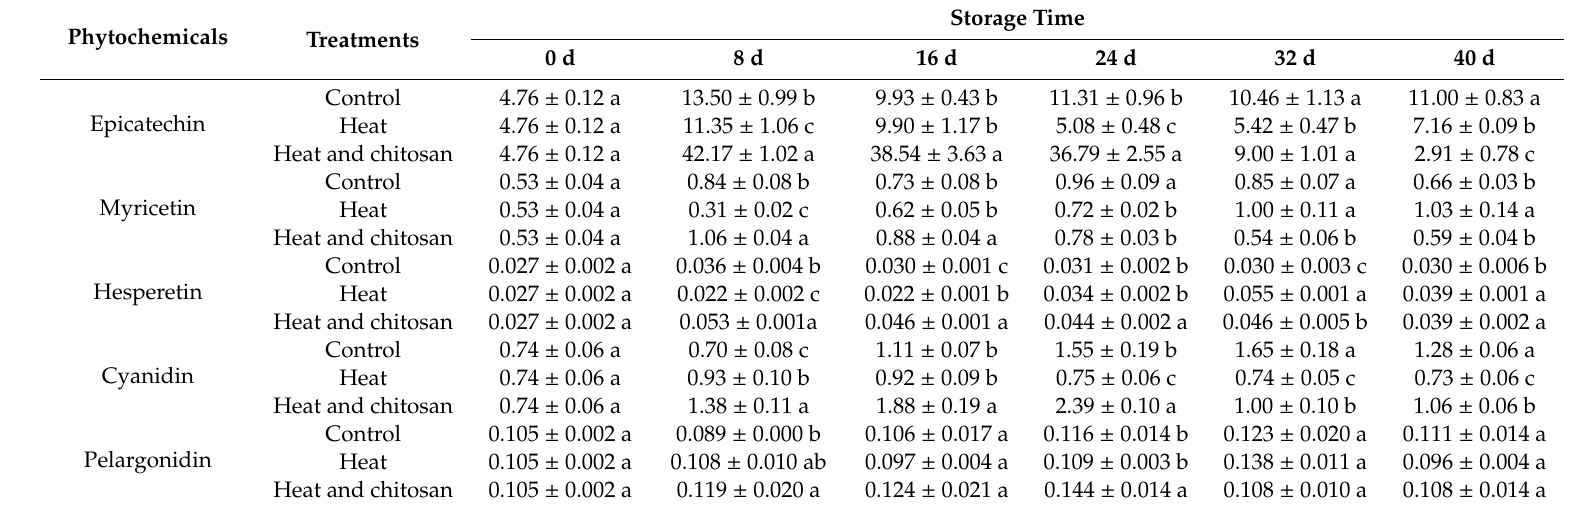
Di ff erent letters indicate significant di ff erences between di ff erent treatments for each compound ( p <